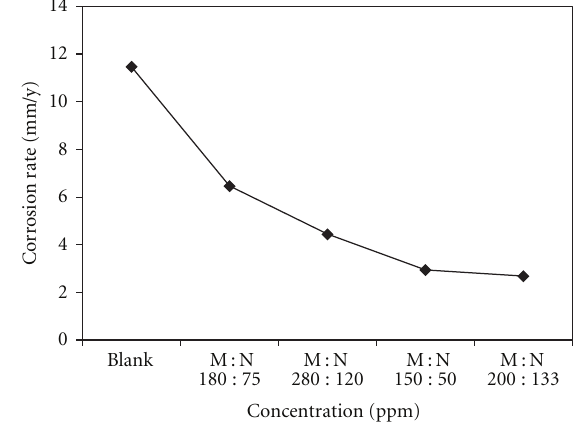
Figure 4: Corrosion rates of Cu-CS as a function of MoO 4 :NO 2 (M:N) ratio concentration.